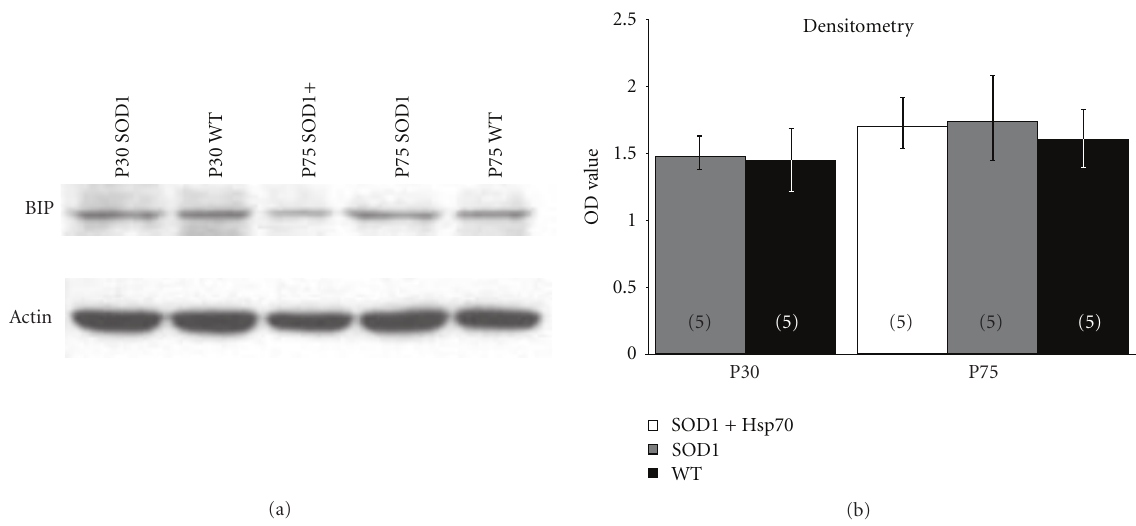
Figure 6: Treatment with rhHsp70 has no e ff ect on ER stress in the spinal cord as determined by BiP expression. (a) Protein extracts were collected from individual lumbar spinal cords and subjected to electrophoresis on a 12% SDS PAGE gel. Proteins were transferred to Immobilon-P membrane, blocked in TBS-T, incubated with a BiP antibody (Cell Signaling) and a donkey anti-rabbit secondary antibody (Jackson Immuno), reacted in ECL, and exposed to X-ray film. (b) Relative levels of BiP were determined using densitometry ( n = 5 blots for each spinal cord). There was only a slight increasing trend in relative levels of BiP when comparing SOD1-untreated to SOD1-treated and WT mice. Statistical significance was determined using a two-way ANOVA followed by Tukey-Kramer post hoc